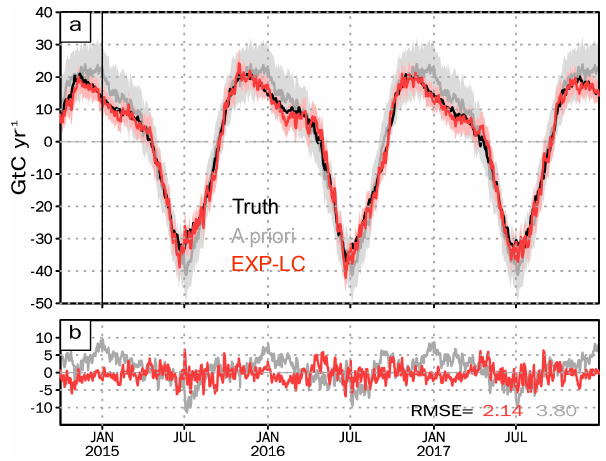
Figure 5. (a) The global daily FTA of truth (black), a priori (gray), and analysis of EXP-LC (red). The vertical line on 1 January 2015 indicates the start of assimilation. Before 1 January 2015, the sys- tem spin-up lasted for 3 months. The pale gray and pale red shadings are the ensemble spread of the a priori and analysis, respectively. (b) The difference compared with the truth. The RMSE at the bottom right corner is the root mean square error of the analysis (red) and the a priori (gray) calculated based on Eq. (12).